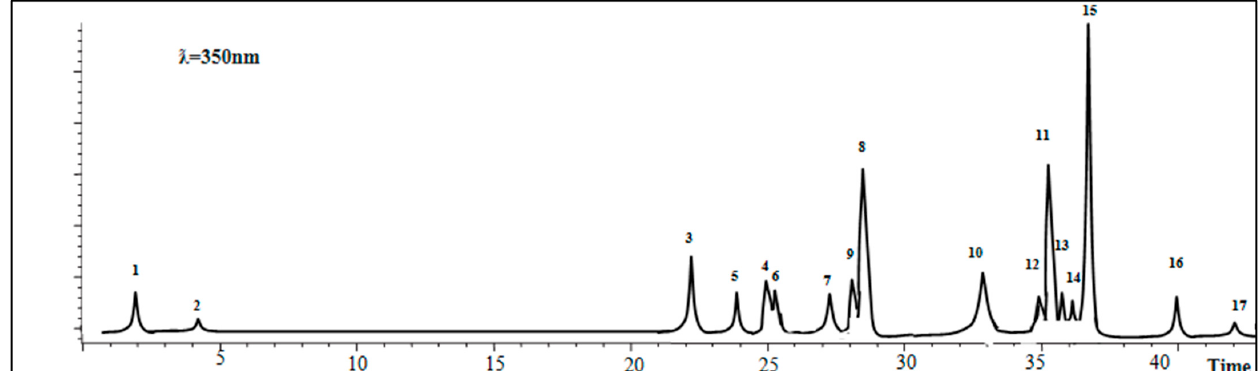
Figure 2. Total ion chromatograms (TIC) of the active extract of A. gombiformis obtained by HPLC–ESI–MS analysis in